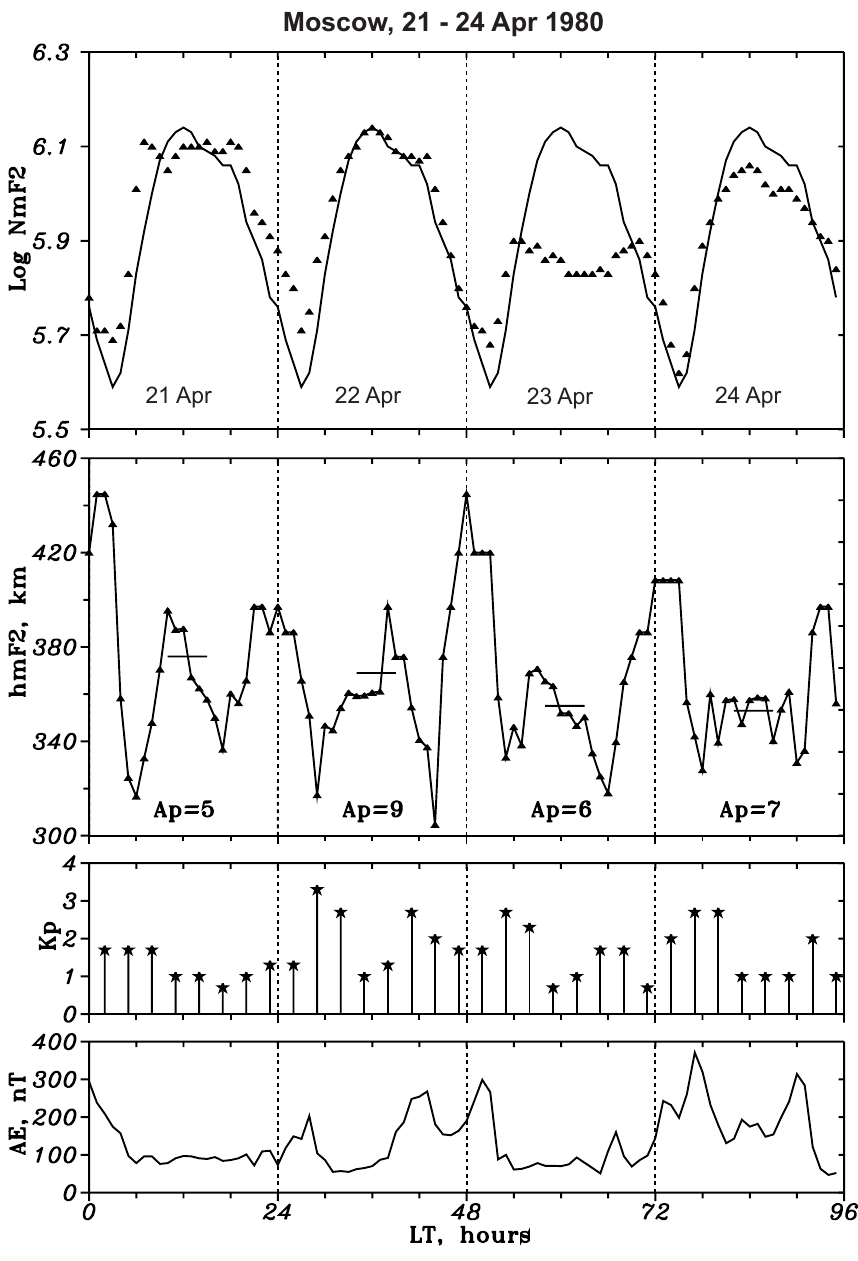
Fig. 3. Same as Fig. 2 but for a strong negative quiet time NmF2 deviation ob- served at Moscow on 23 Apr